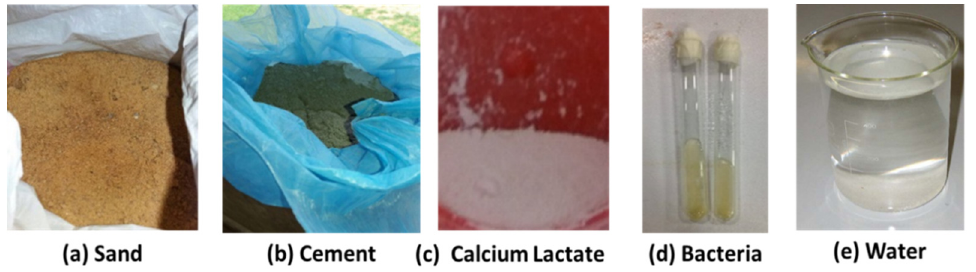
Fig. 3(a-e): Raw Materials used in Experiments